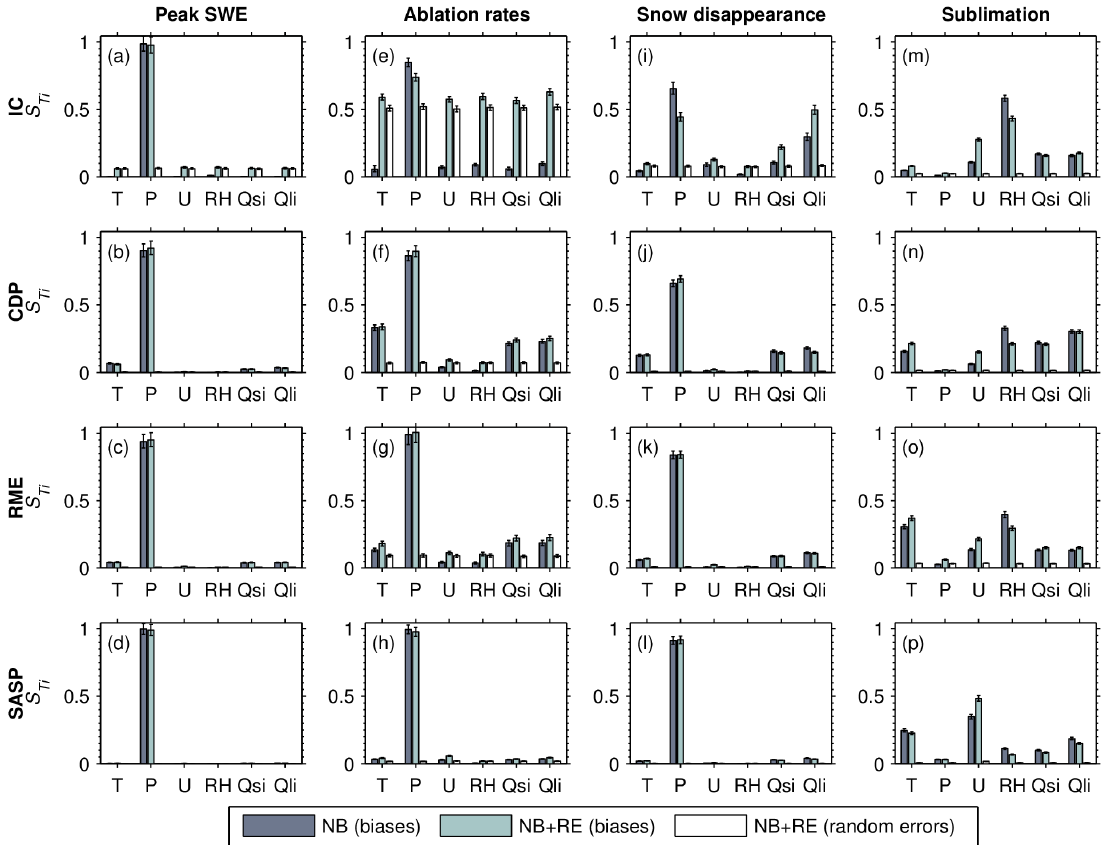
Figure 5. Model sensitivity as a function of forcing error type. Shown are the total-order sensitivity indices ( S T i ) of four model response variables (columns) at the four sites (rows) from scenarios NB and NB + RE. In NB + RE, bias and random error parameters are shown separately. NB + RE considers normally distributed bias and random errors, while NB considers normally distributed bias only. The bar indicates the mean (bootstrapped) sensitivity indices and associated 95% confidence